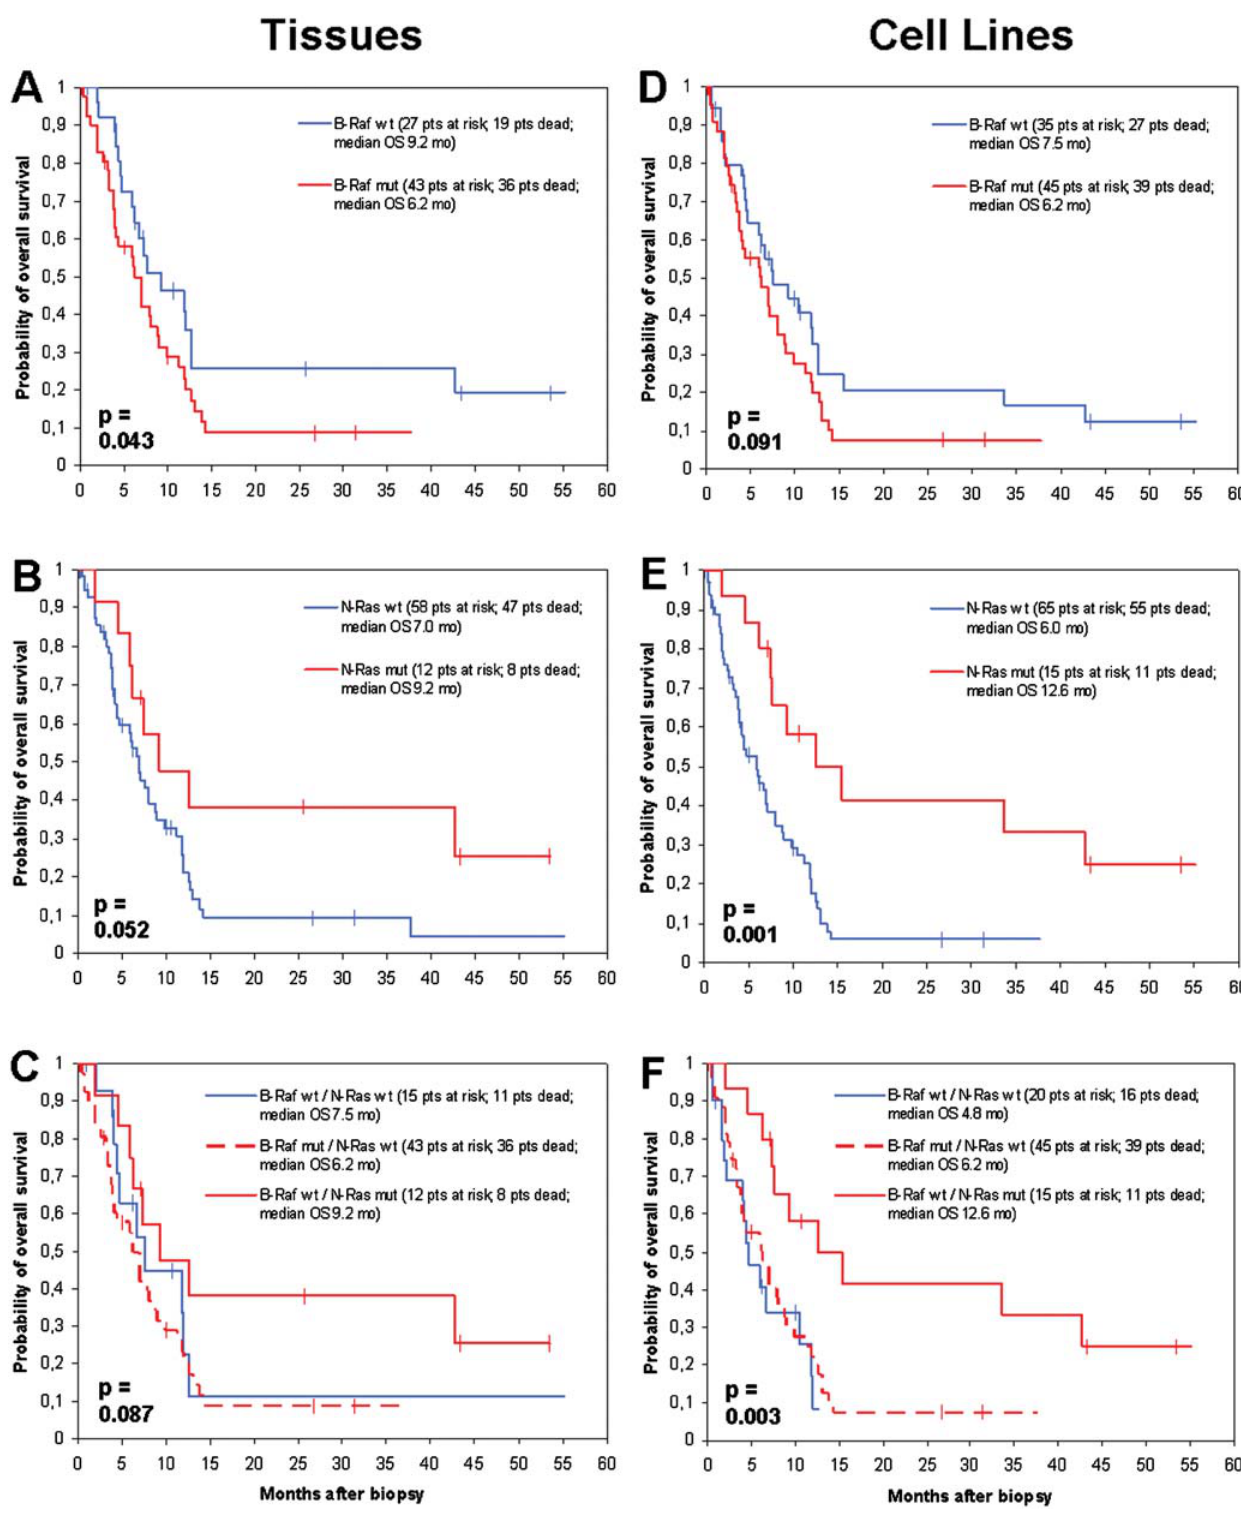
Figure 4. Kaplan-Meier survival estimation for stage IV patients only by mutational status. Curves showing the overall survival starting with the time point of tumor biopsy in 82 metastatic melanoma patients who were in stage IV disease at that time. Survival probabilities were compared by the mutational status of B-RAF in tumor tissue biopsies (n=70) (A) and biopsy-derived tumor cell lines (n=80) (D) , as well as N-RAS in tumor tissue biopsies (n=70) (B) and biopsy-derived tumor cell lines (n=80) (E). (C) and (F) differentiate patients harbouring B-RAF mutations (n=43, tissues; n=45, cell lines), patients harbouring N-RAS mutations (n=12, tissues; n=15; cell lines), and patients without mutations in both genes (n=15, tissues; n=20, cell lines). Statistical differences between groups were calculated using the log-rank test. Vertical bars indicate censored observations.